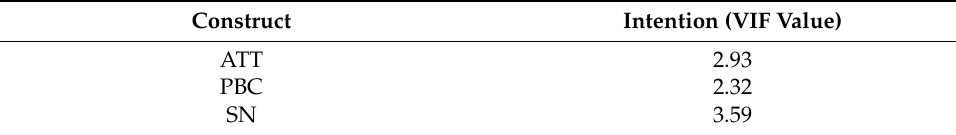
Table 3. Lateral collinearity